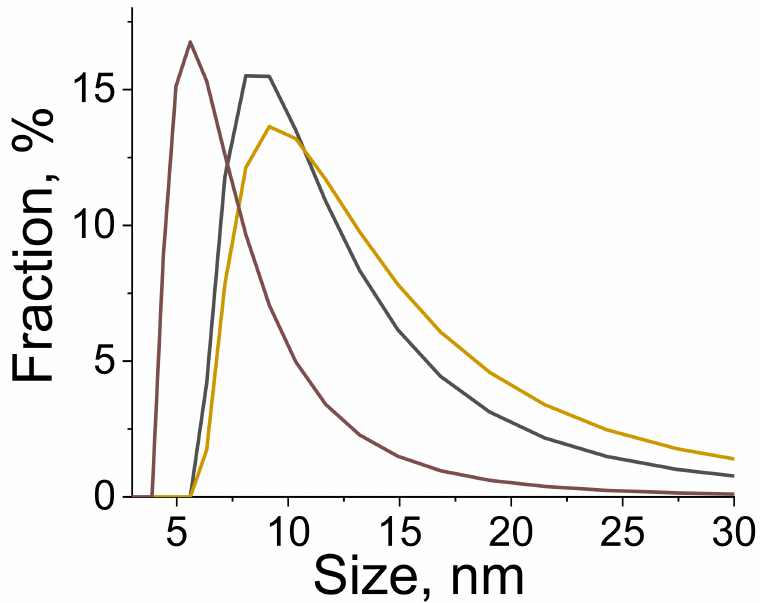
Figure 3. The particle size distribution of the aqueous solution of 3 is revealed by dynamic light scattering as a result of three parallel measurements. The average particle size is equal to about 8 ± 2 nm (spherical approximation).